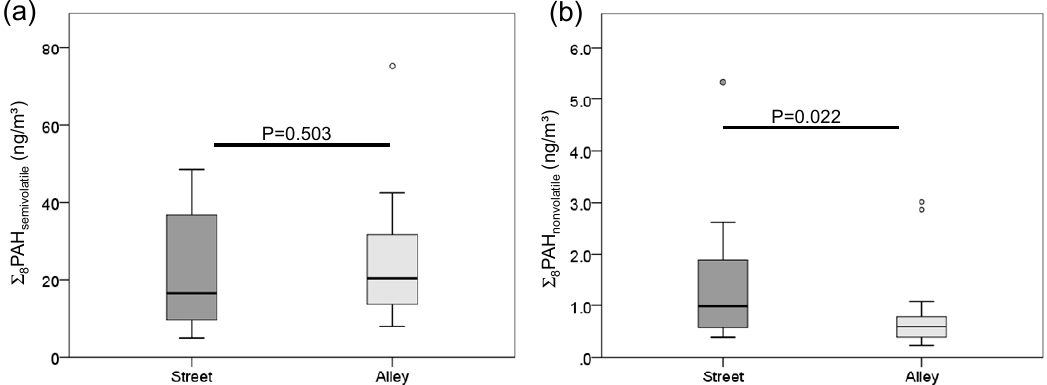
Figure 3. Neighborhood-wide comparison of residential outdoor ( a ) Σ 8 PAH semivolatile and ( b ) Σ 8 PAH nonvolatile levels in NYC: street vs. alley. Note: Geometric mean concentrations and 95% confidence intervals presented. Mann-Whitney test performed to compare PAH concentrations measured from the street side of buildings vs. the alley side of buildings across the neighborhood wide sample.